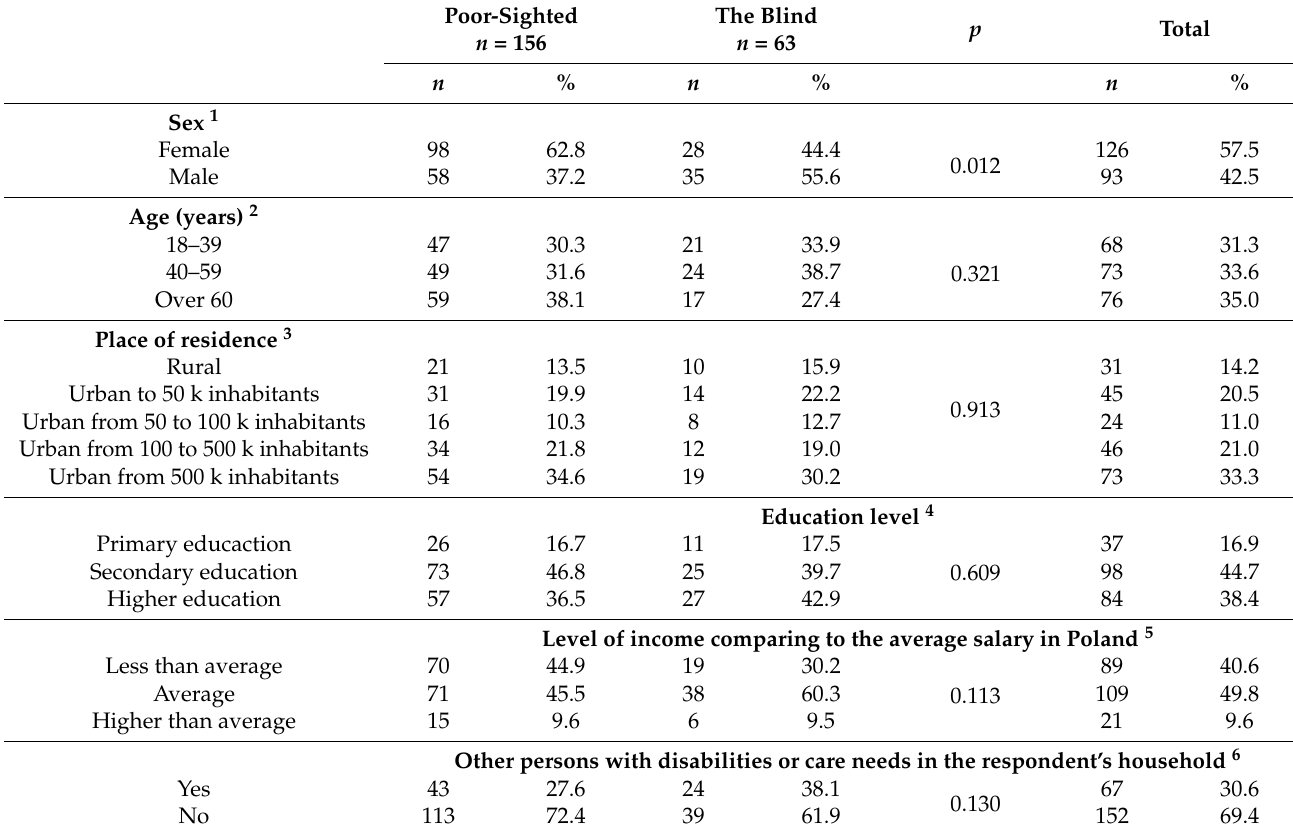
Table 1. Sociodemographic characteristic of the study